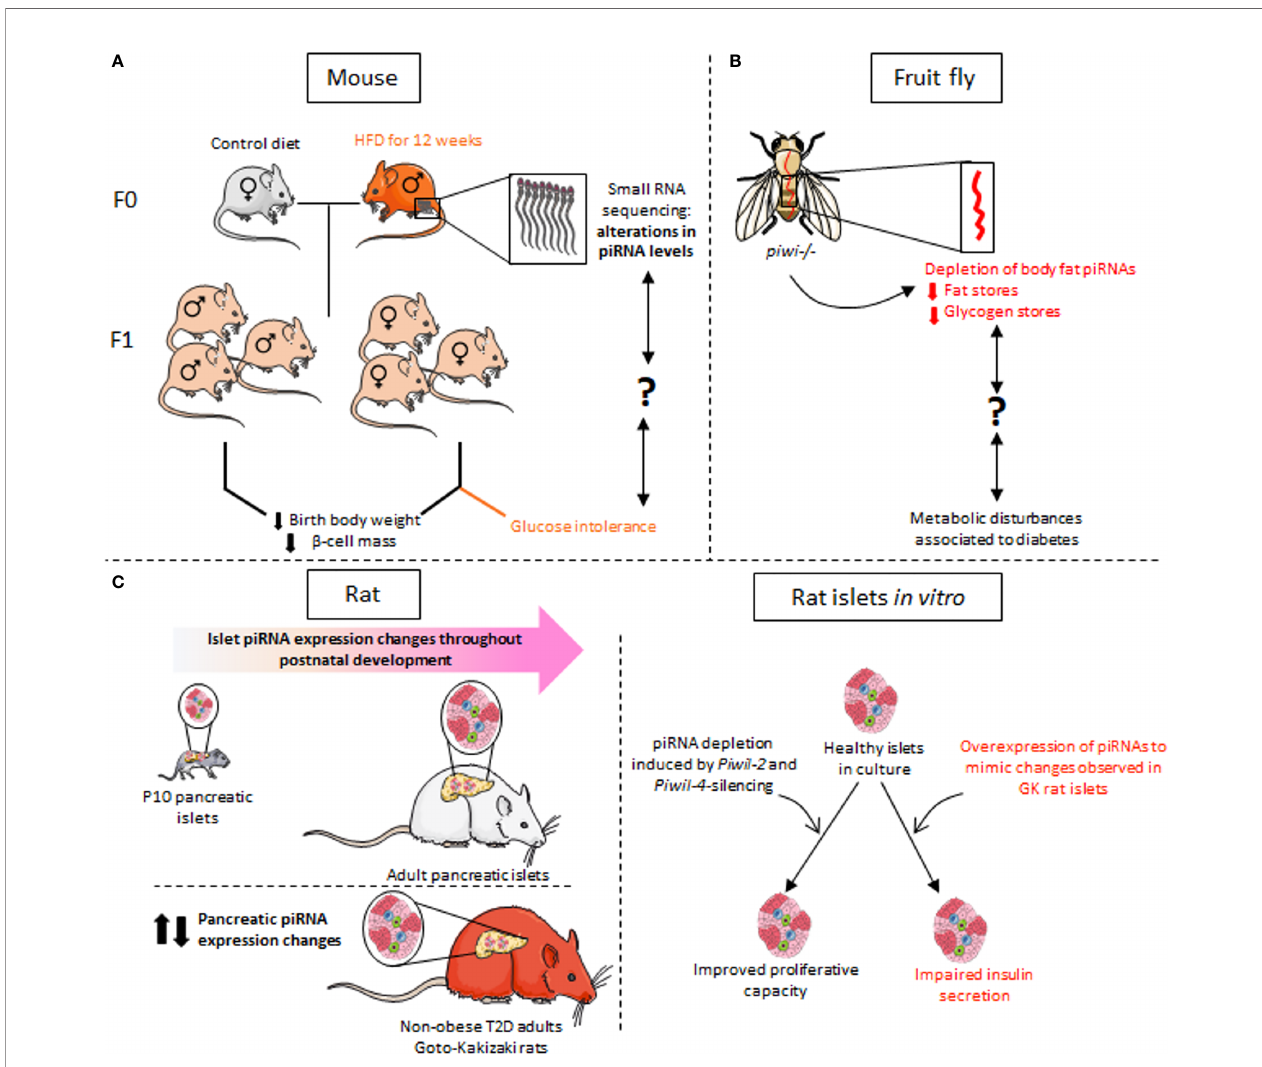
FIGURE 5 | piRNA dysregulation in the context of metabolic disorders. (A) RNA-sequencing of sperm from progenitor males fed for 12 weeks on a high-fat diet (HFD) revealed alterations in the expression of many small non-coding RNAs, including piRNAs. F1 animals have reduced birth weight and decreased b -cell mass. Glucose intolerance is observed exclusively in F1 females. (B) In a piwi-mutant Drosophila model, depletion of piRNAs in the fat body, which has functions equivalent to mammalian liver, results in defects in glucose and lipid metabolism as observed in metabolic disorders such as diabetes. The link between the decline in piRNA expression and the observed metabolic phenotype remains however to be established. (C) The expression pro fi le of piRNAs in rat islet cells changes during postnatal development and b -cell maturation. Dysregulation of piRNA levels is also observed in the islets of non-obese diabetic Goto-Kakisaki (GK) rats. In vitro experiments mimicking the changes in the level of certain piRNAs observed in GK rats result in defective insulin secretion of healthy rat islets in response to glucose. Depletion of piRNAs secondary to silencing of the PIWI-like genes Piwil2 and Piwil4 in adult islets promotes b -cell proliferation, which is normally very low in